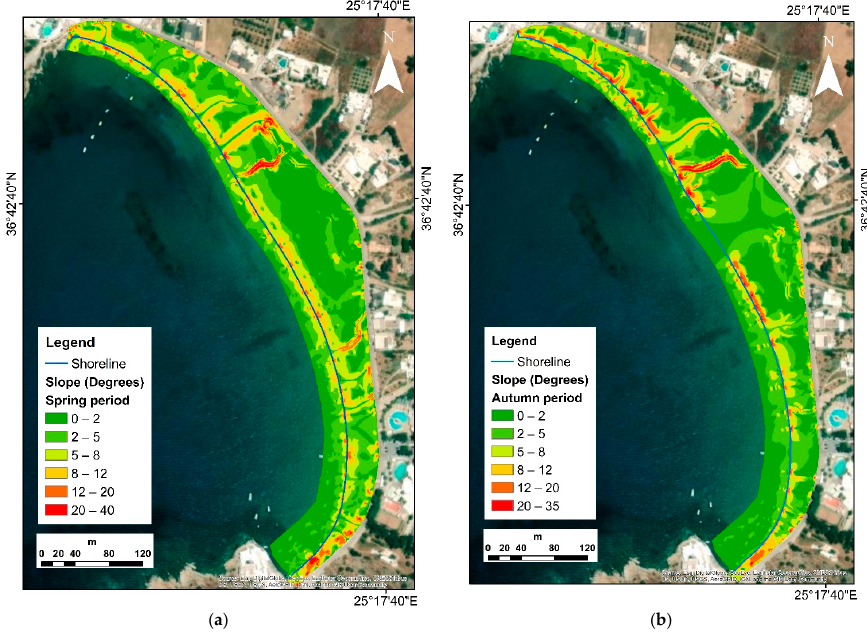
Figure 10. Map of morphological slopes of Mylopotas beach. ( a ) Shows the slope values from seaward to landward for the autumn period. ( b ) Shows the slope values from seaward to landward for the spring period. The left figure shows the slope values from seaward to landward for the autumn period. At Magganari beach, the elevations at the landward part of the beach mostly ranged between 0.40–1.20 m for both seasons (Figure 11). According to the map of morphological slopes, gentle slopes prevailed at most of the beach. The berm zone is identified along the coastline and preserved from April to September, with slope ranges between 10°–22°, with a maximum value of 25° during the autumn period (Figure 12).